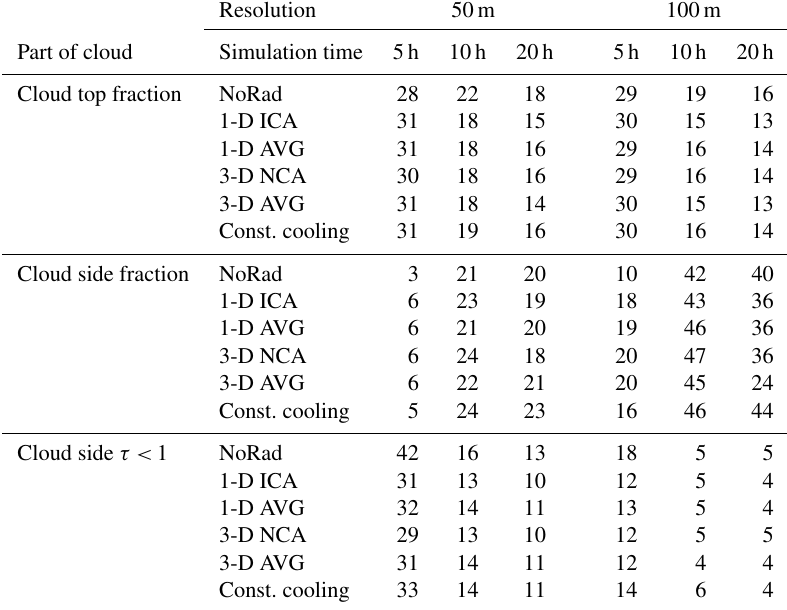
Table 3. Percentage fraction of cloud side and cloud top grid boxes per total number of cloudy grid boxes at 5, 10 and 20h of the 50 and 100m simulations as well as the percentage fraction of cloud side grid boxes with an optical thickness (at 550nm) lower than